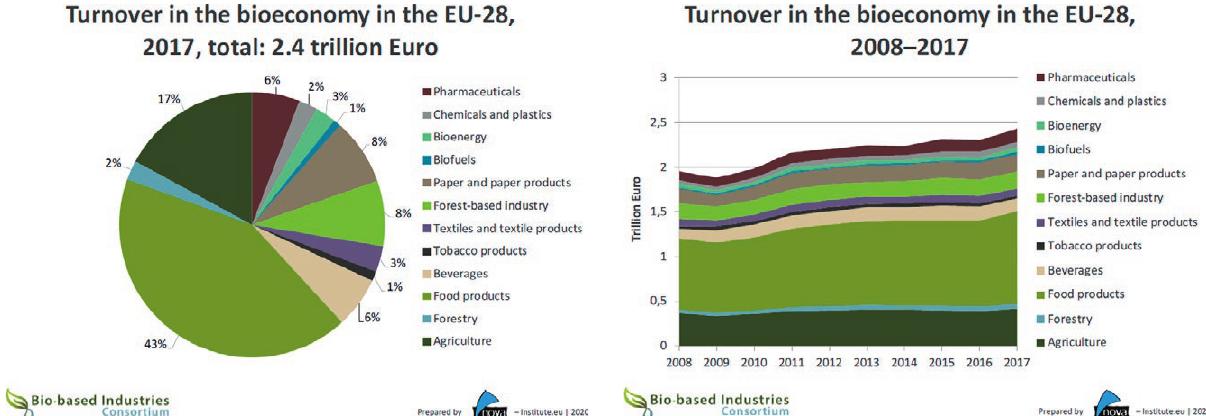
Figure 1. Turnover in the Bioeconomy in EU 28: percentage between sectors and trends over 2008-2017 (Porc et al.,